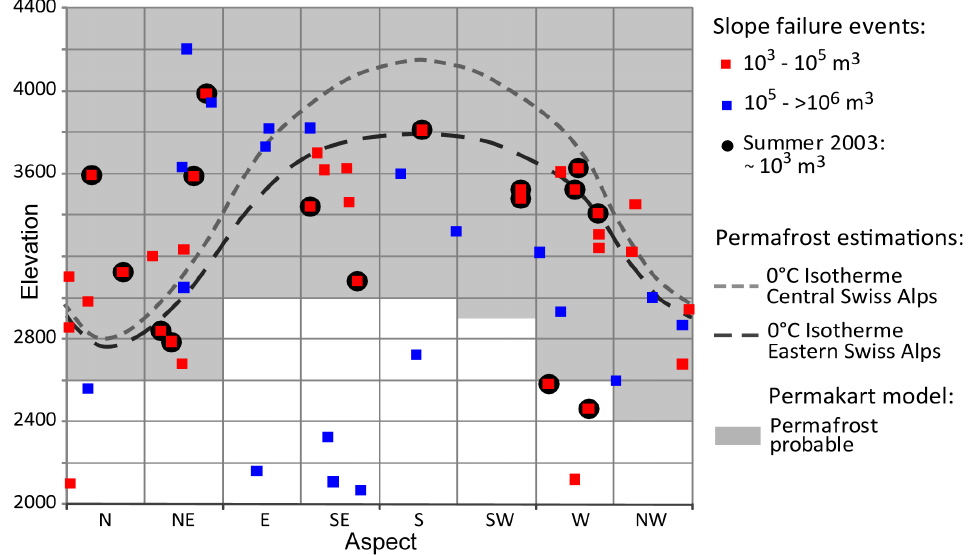
Fig. 11. The altitude of the detachment zones related to slope aspect as a first-order information about the permafrost setting, in relation to the assumed lower permafrost boundaries based on two approaches (adapted from Keller, 1992 and Gruber et al.,